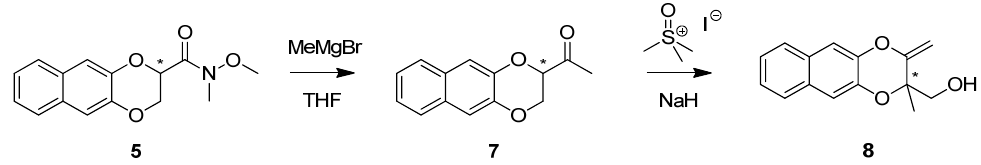
Figure 2. Structure of 8 , obtained as the main product while treating 7 with dimethylsulfoxonium methylide in DMSO at RT (* no defined chiral center).